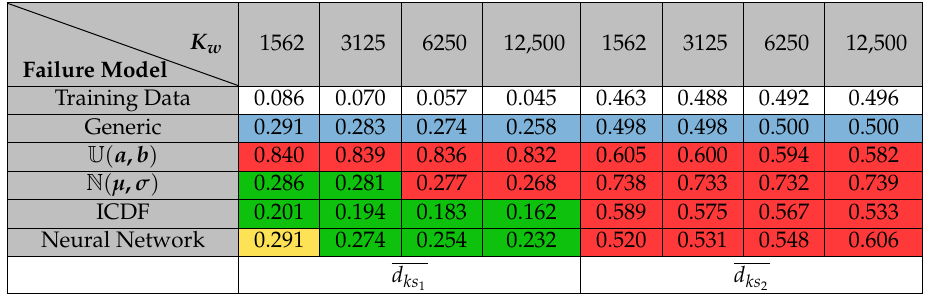
and d ks for failure amplitudes of the Sharp sensor with varying window 2 1